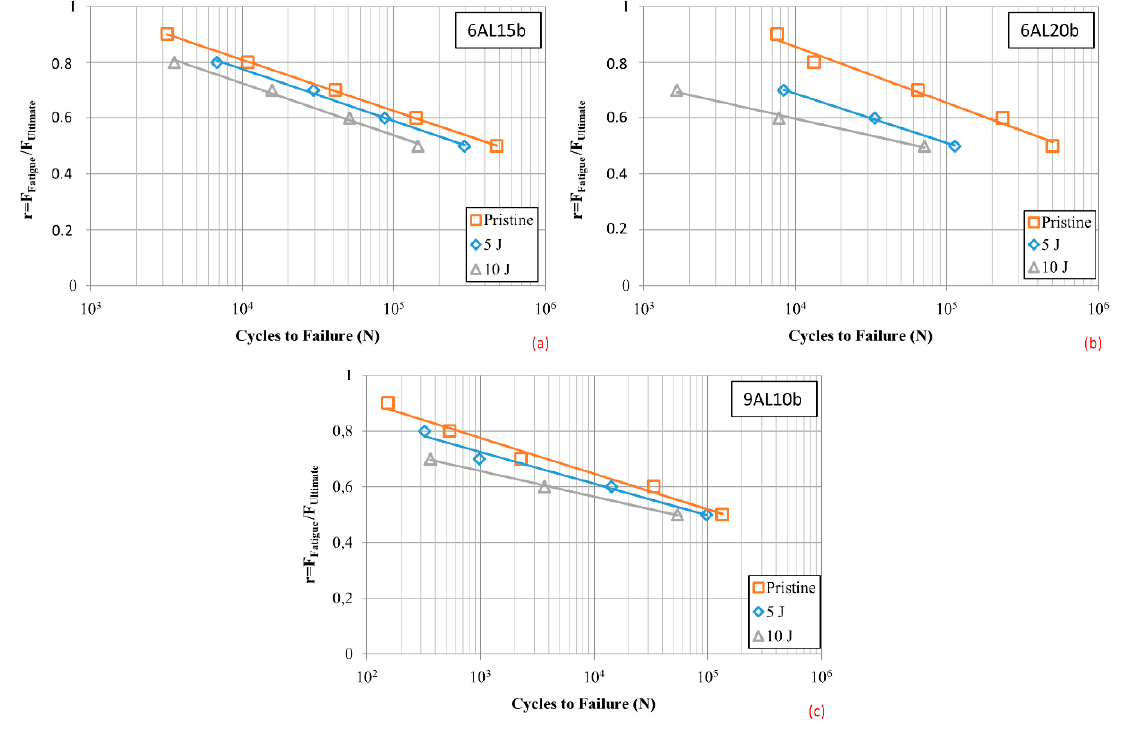
Figure 8. Loading ratio vs. cycles to failure graphs for the ( a ) 6AL15b, ( b ) 6AL20b and ( c ) 9AL10b specimens.